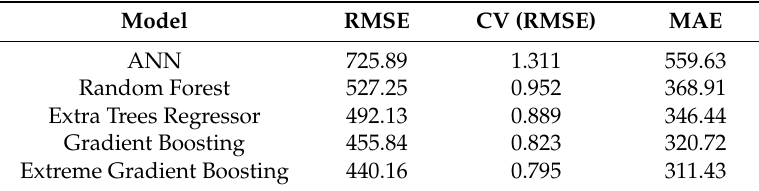
Table 1. Performance Metrics of ANN and Ensemble Models.